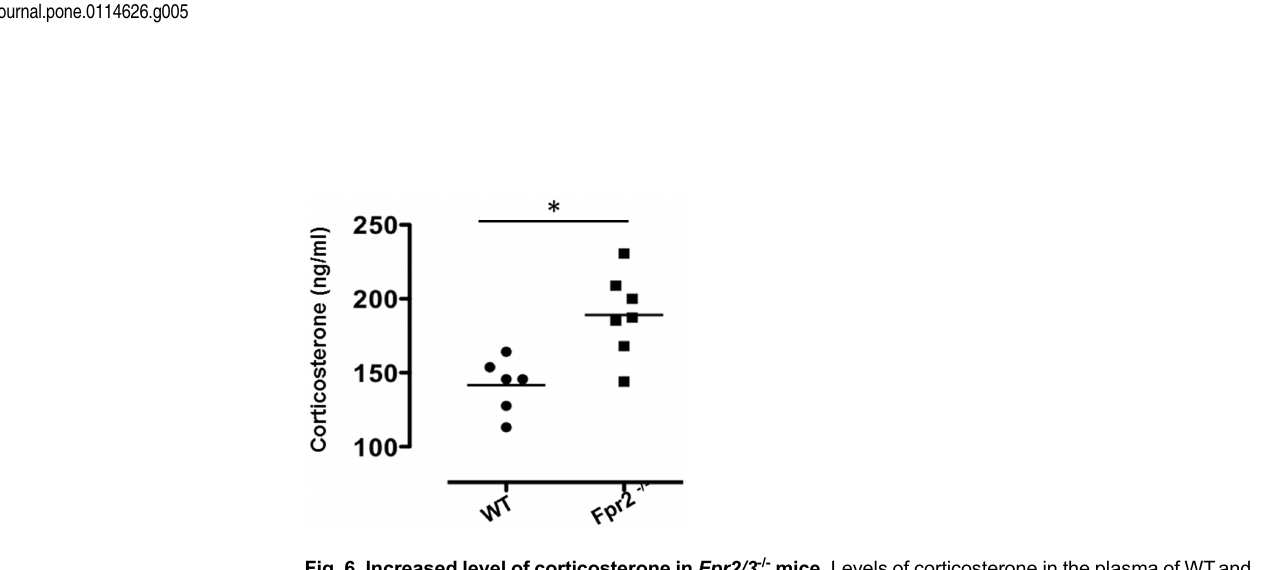
Fig. 5. Increased discriminatory activity of Fpr2/3 -/- mice in the novel object recognition test. The bar graph in A shows the total time (seconds) spent exploring the objects used in the test (shown in the top picture) during the 10-minute acquisition phase (left panel) and the % of time spent on the novel object (shown in the bottom picture) in the subsequent 5-minute test phase (right panel). The bar graphs in B show the total number of arm entries and spontaneous alternation percentage (calculated as described in material and Methods section) in the Y-maze during a 5-minute trial. Values are expressed as median ¡ S.E.M. and representative of n 5 4 different experiments involving 6–9 mice per group. ** P , 0.05 indicates significant values compared with wild-type (WT) control mice (Mann–Whitney U -test).